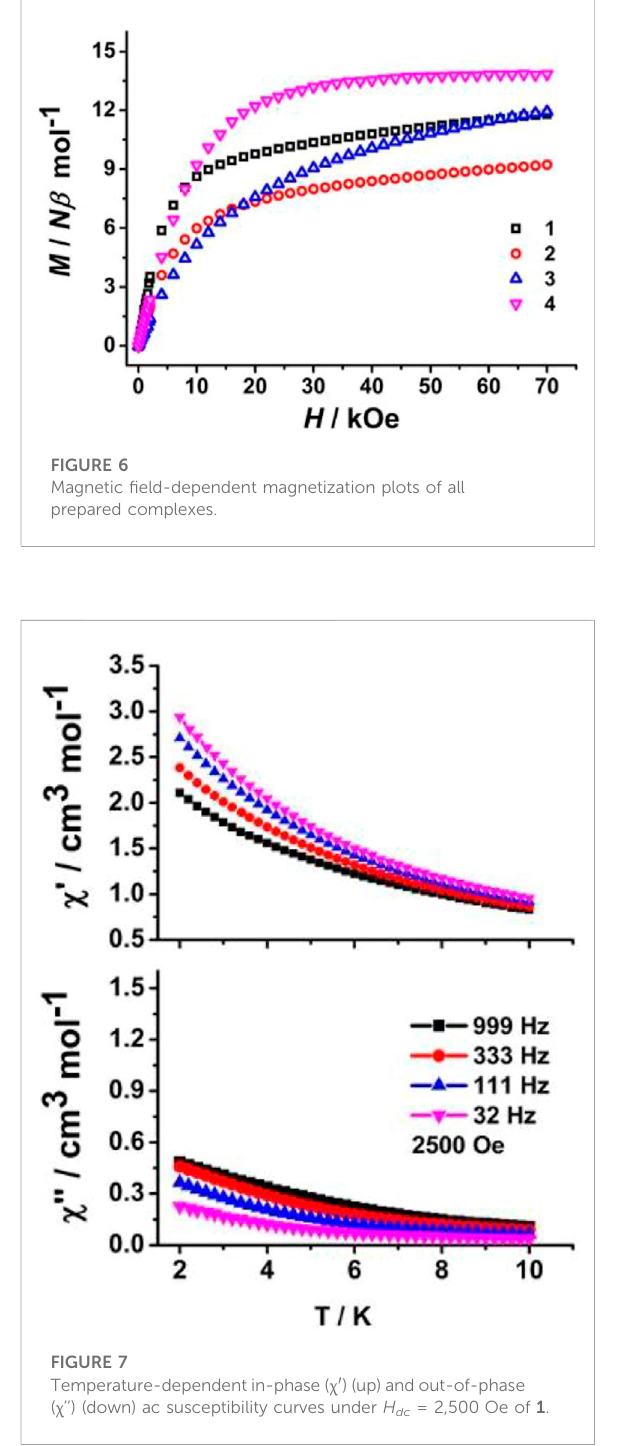
antiprism (SAPR, D 4d ) conformation (Figure 2B) with calculated CShM value S = 1.619. As shown in the crystal packing diagram of 1 (Figure 4), no special intermolecular interactions can be found with the shortest intermolecular distance between dysprosium (III) ions of 9.844 (3) Å.